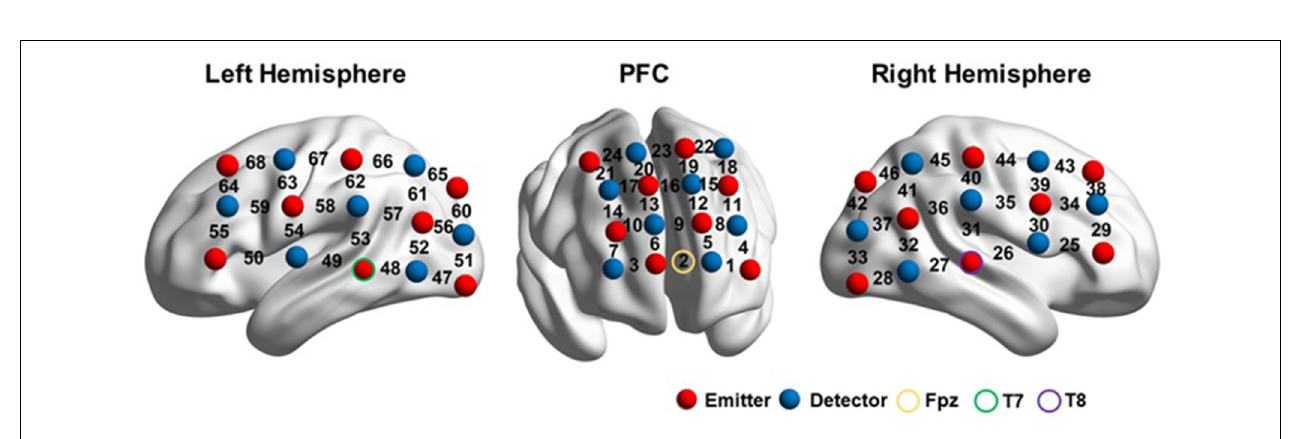
FIGURE 2 | fNIRS setup. The image was visualized with the BrainNet viewer (http://www.nitrc.org/projects/bnv/; Xia et al.,